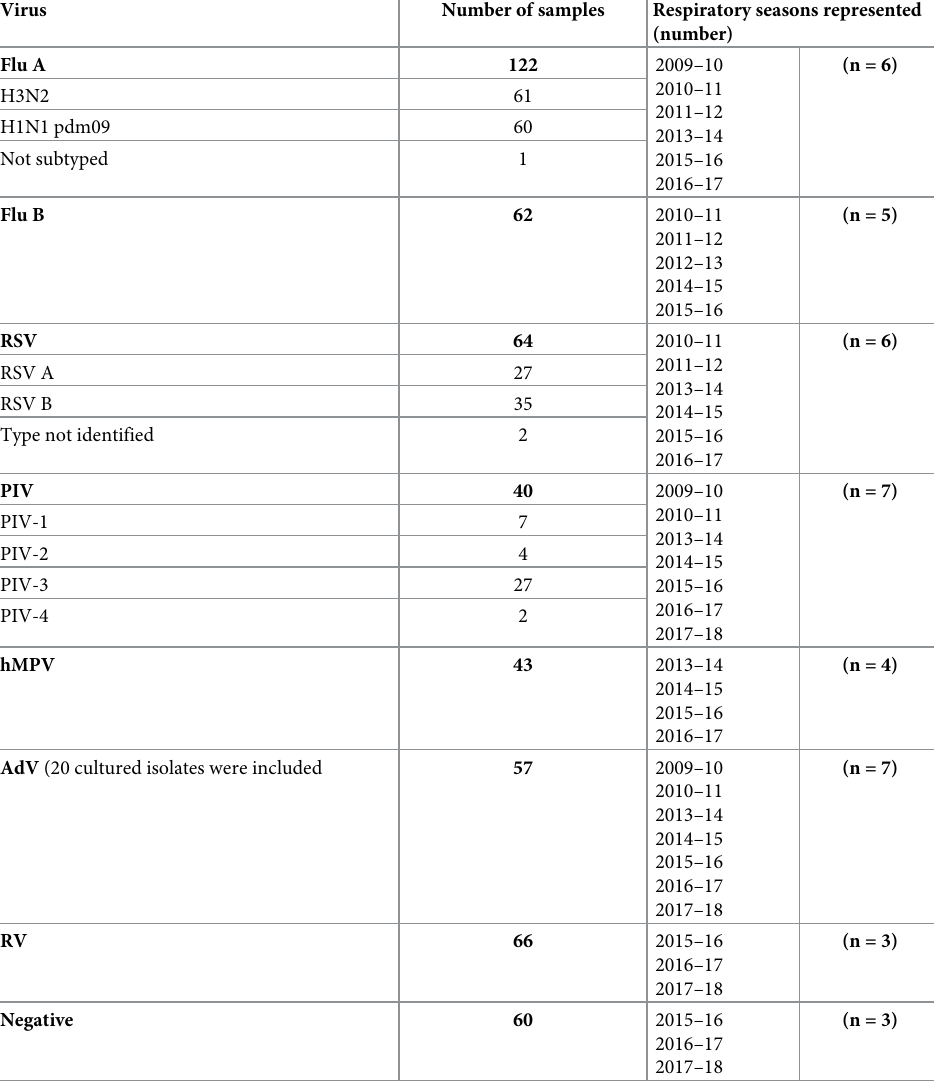
Table 2. Samples included in the retrospective part of the study classified according to their viral etiology and year of collection. Virus Number of